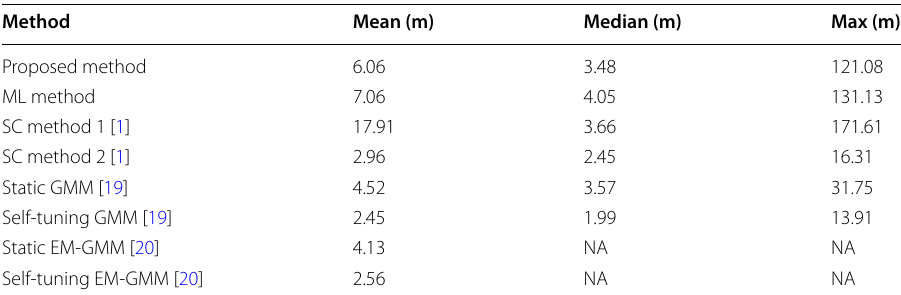
Table 6 Localization errors (m) of the proposed method and the existing SC [1], GMM [19] and EM-GMM [20] approaches using the GPS